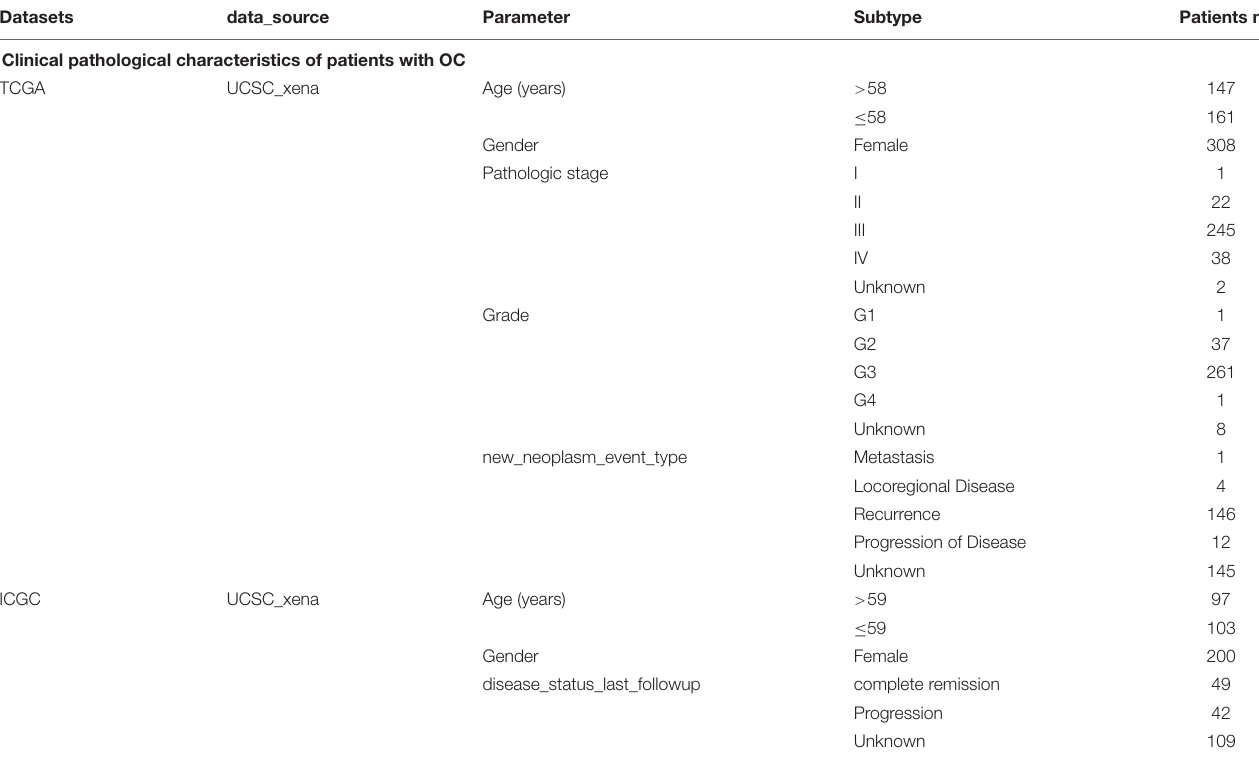
TABLE 1 | The clinical information of the validated ovarian cancer